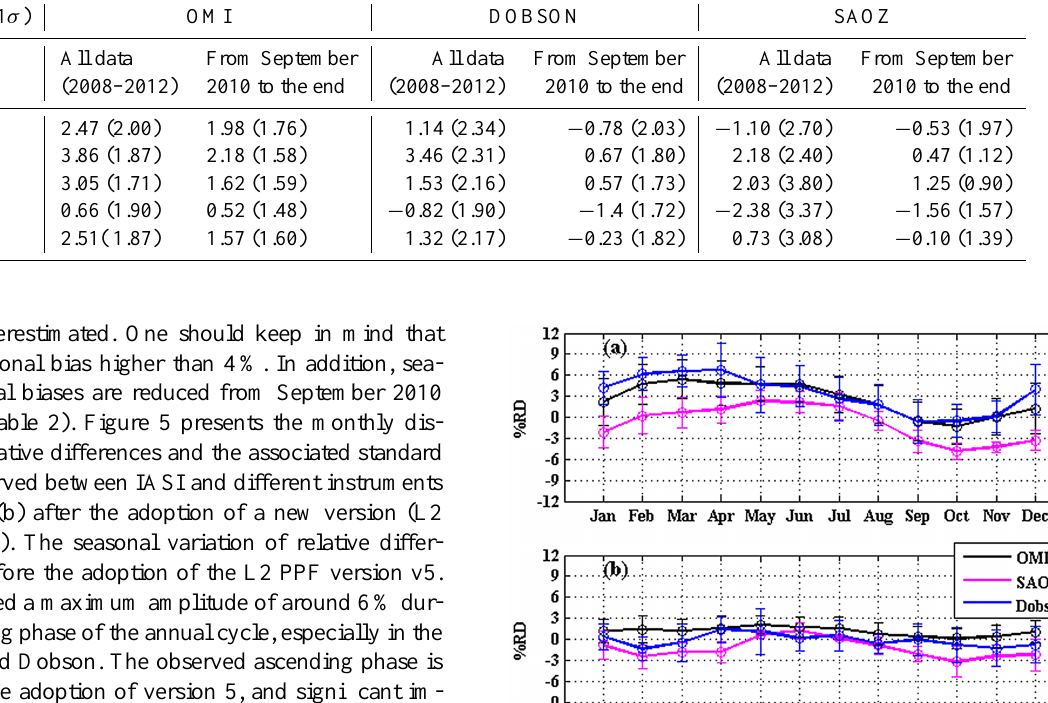
Figure 5. Monthly distribution of relative differences recorded be- tween IASI and the other instruments (OMI SAOZ and Dobson): (a) from June 2008 to August 2010 and (b) from September 2010 to December 2012. The error bar is the standard deviation associ- ated with the monthly mean